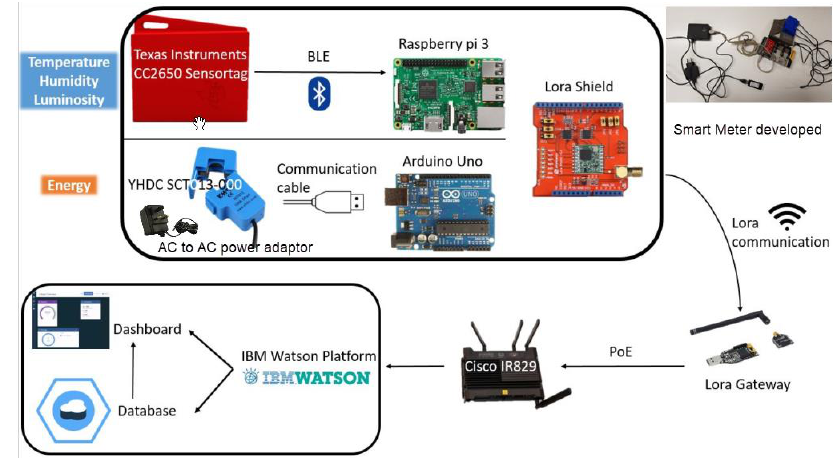
Figure 1. Implemented Long-Range (LoRa) network architecture based on Cisco equipment.